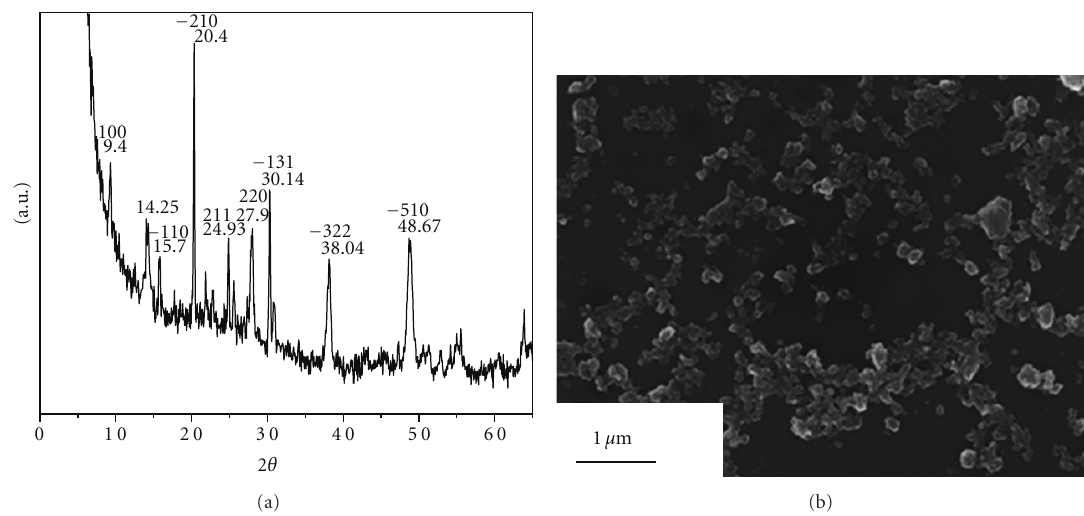
Figure 1: (a) XRD pattern and (b) FESEM of SAPO 34 crystals used as seed for membrane